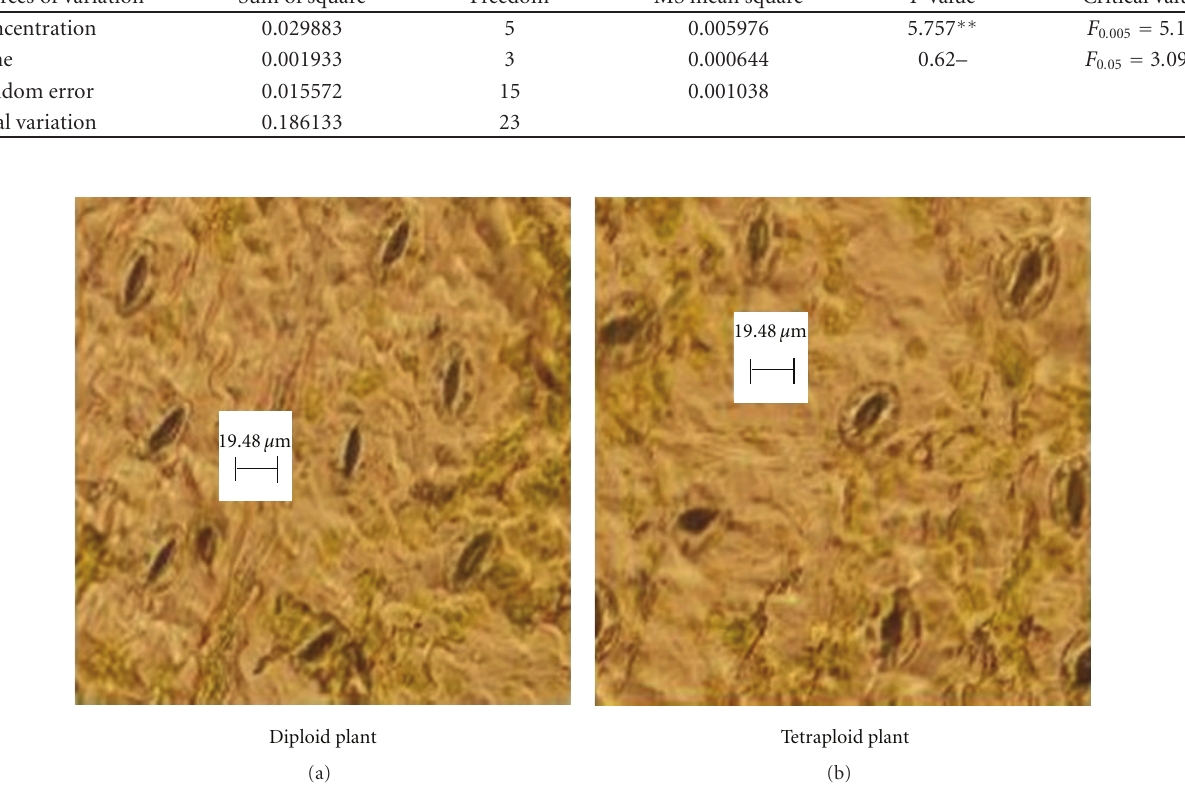
Figure 3: Stomatain abaxial leaf epidermis under fluorescence microscope of diploid (a)and tetraploid (b) of C. roseus . Scale bar is 19.48 μ